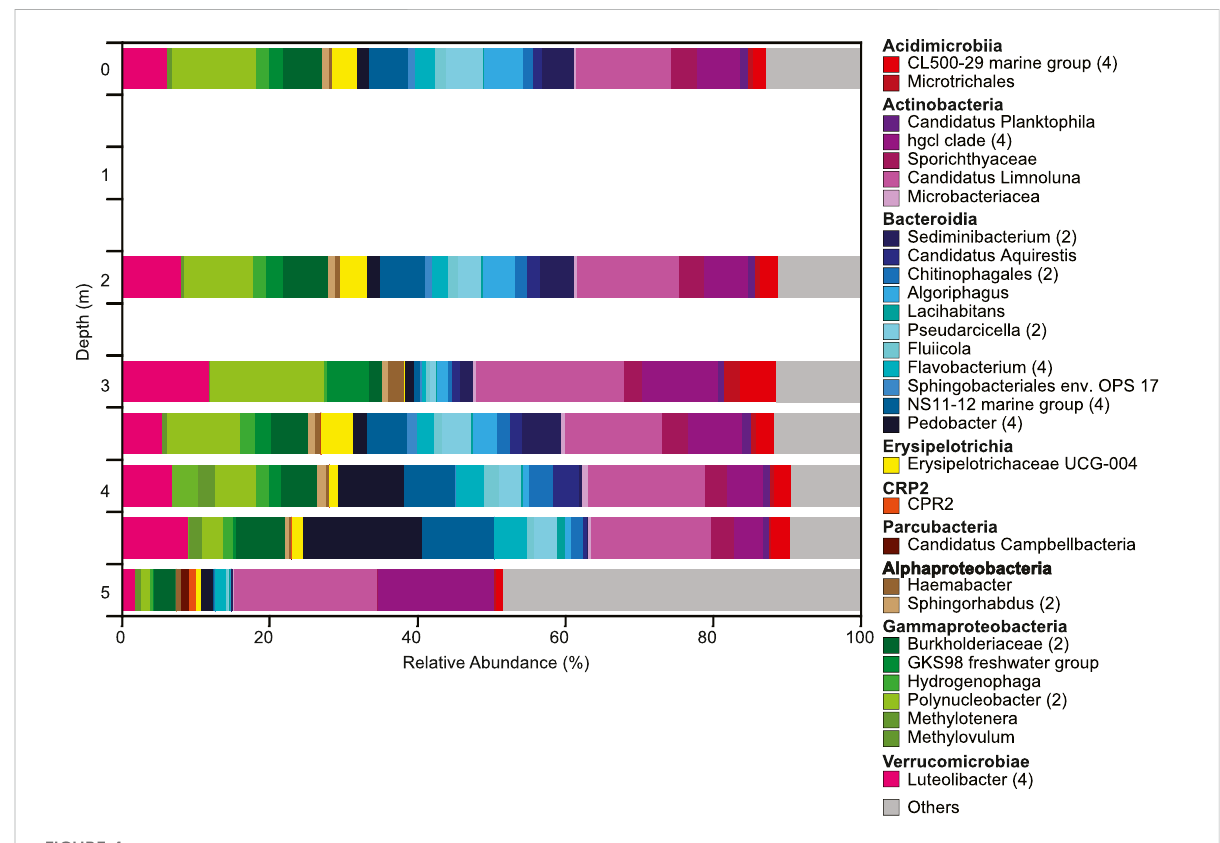
FIGURE 4 Depth pro fi le of microbial community composition down the water column based on changes in the relative abundances of 16S rRNA gene sequences. All ASVs with a relative abundance > 1% are shown. ASVs with identical identi fi cation were combined into the same taxonomic group.ASVswitharelativeabundance < 1%arecombinedinthecategory ‘ others ’ .ThenumberofASVsincludedineachtaxonomicgroupisincluded with the number given after the taxonomic name. If no number is given, the group only contains one